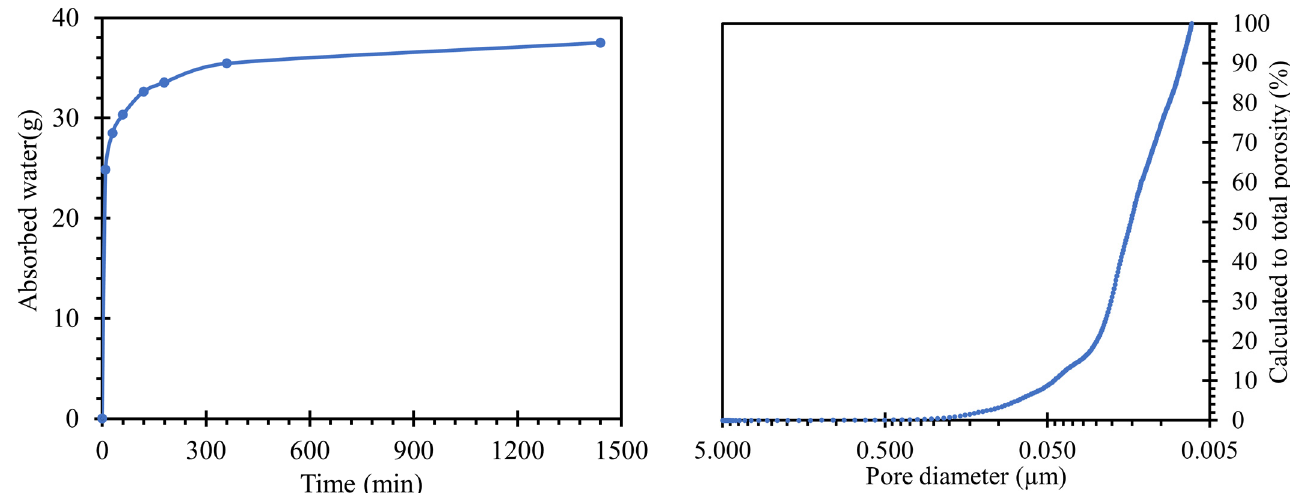
Figure 3. Left —results of the water absorption test of the test specimens indicating the amount of water absorbed over time; right —determined porosity, converted to total porosity in the range of 0.005 to 5 µm, measured by MIP.